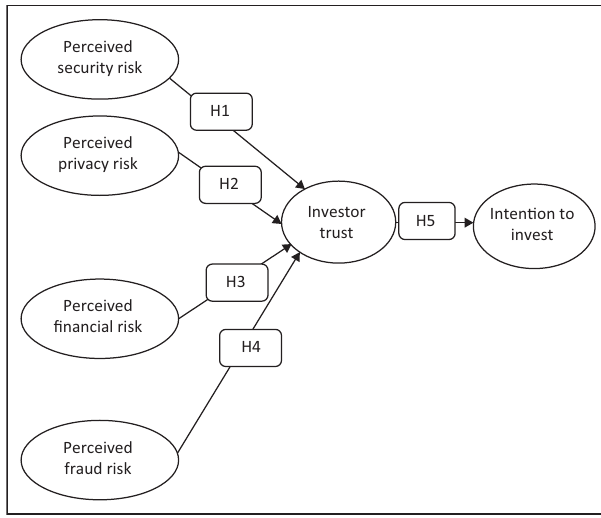
FIGURE 2: Conceptual